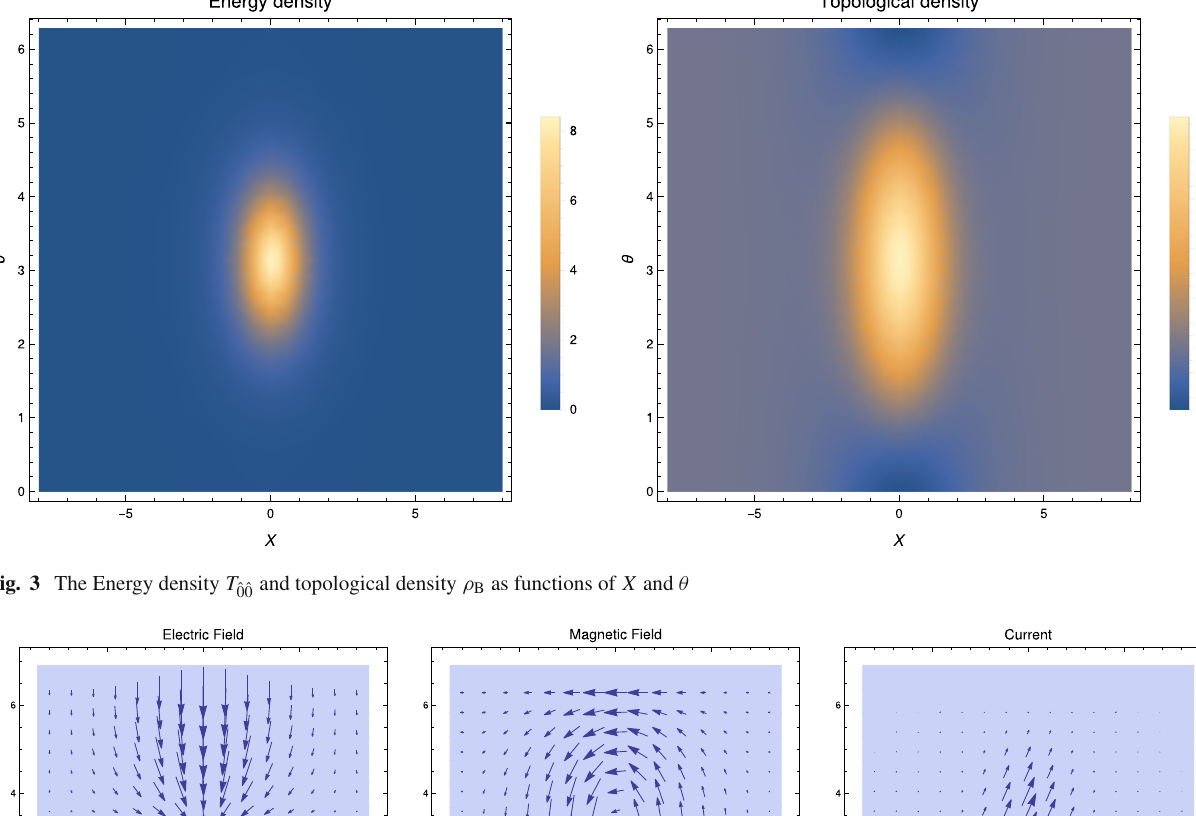
and topological density ρ B as functions of X and θ 0 ˆ 0